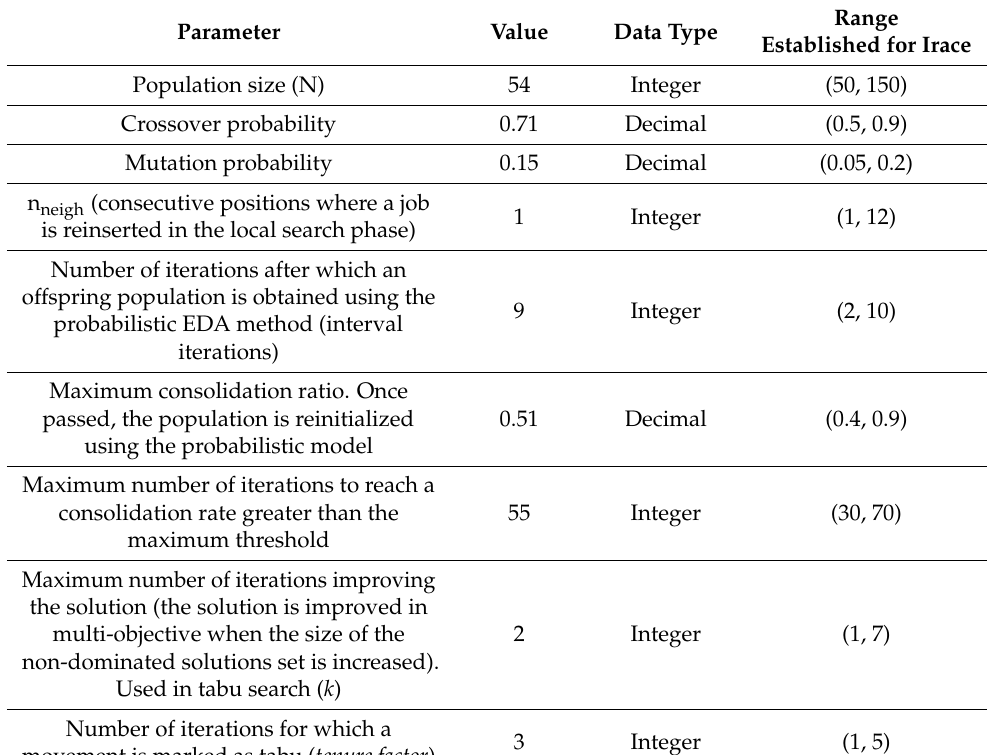
Table 1. Automatic HDNSGA-II configuration via